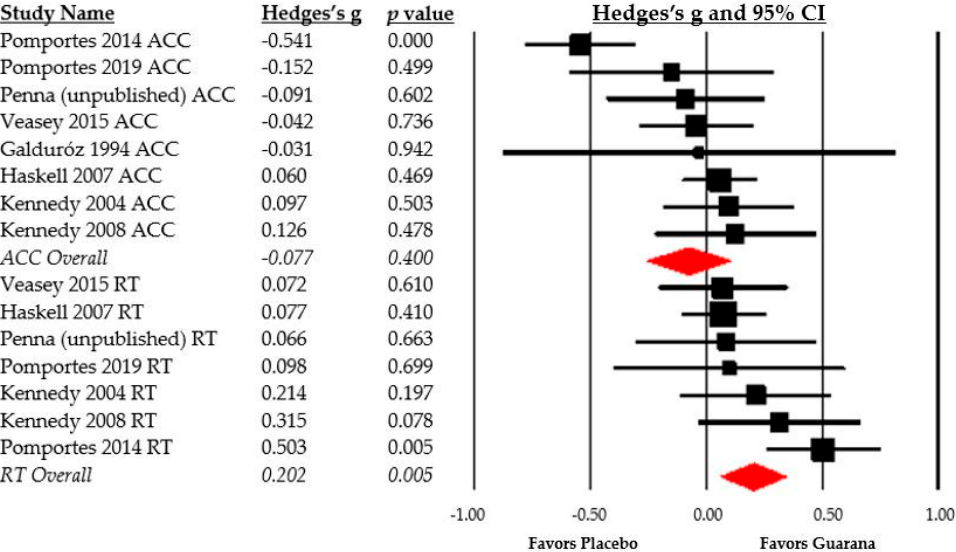
Figure 3. Forest plot of effect sizes for subgroup meta-analysis comparing accuracy (top) and response time (bottom). The red diamond represents the effect size and the CI for each group. ACC = accuracy and RT = response time [16–19,21,22,34,35].